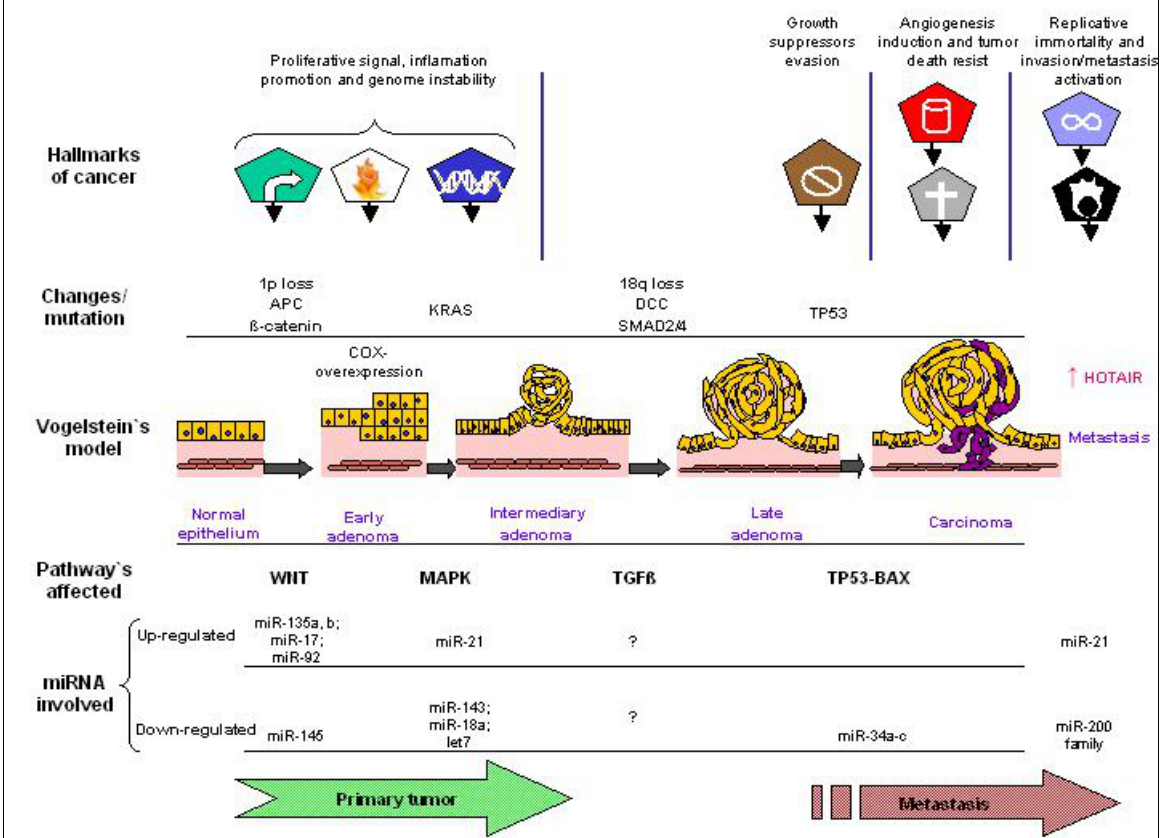
Figure 2. Connection between emerging hallmarks of each acquired capabilities necessary for tumor growth and progression [23] and, Vogelstein’s model of CRC pathogenesis [63]. MicroRNAs’ involved in each way and emerging linc-HOTAIR implication in metastasis